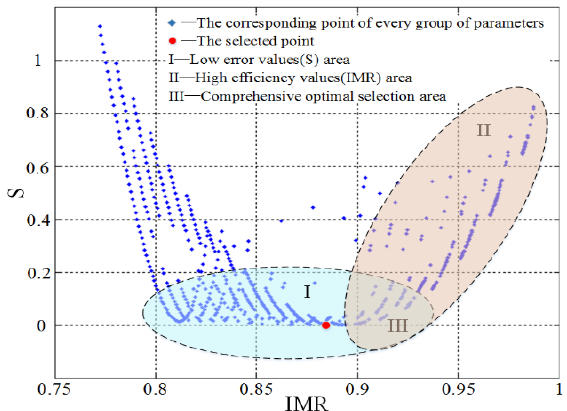
Figure 7. Waveform error and impulse magnification ratio ( S-IMR ) diagram of the parameter optimization. The selected initial values are as follows: L m = 0.9 H, C 1 = 10 µF, R 1 = 1155 Ω, C 2 = 0.1 µF, and R 2 = 10 Ω. The value ranges of C 2 and R 2 are (0.1, 2) µF and (10, 80) Ω, respectively. The step